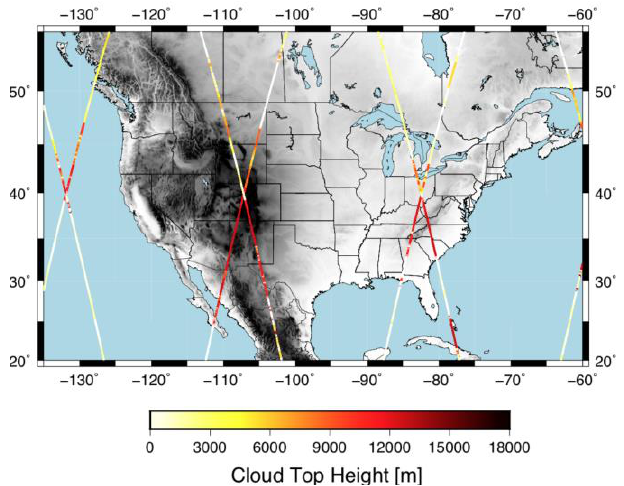
Figure 1. Cloud top height retrievals from CALIPSO during 1 April 2018.